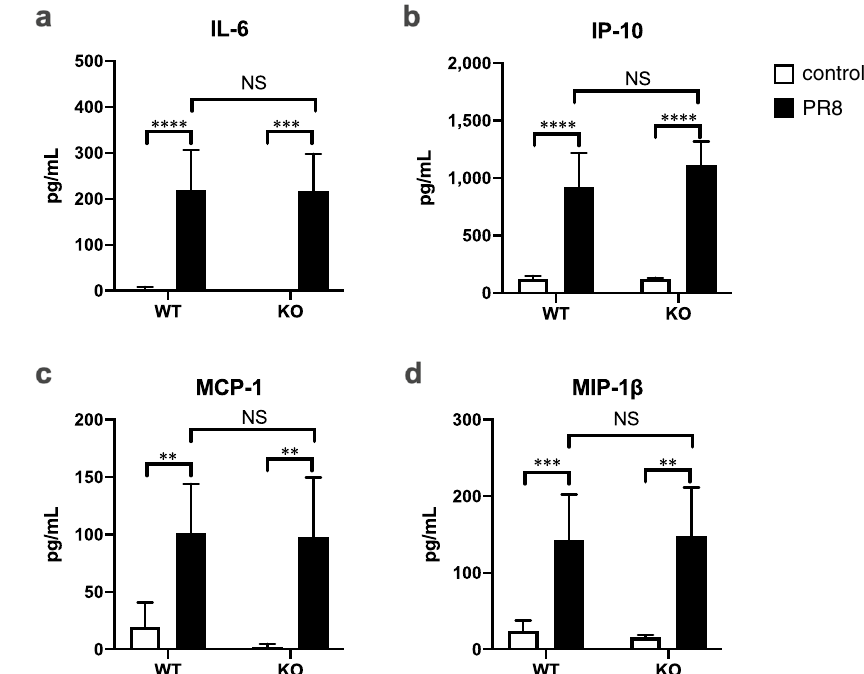
Figure 5. Effect of OLR1 on virus infection-induced systemic inflammation. WT and KO mice were intranasally inoculated with PBS alone or PBS comprising PR8 virus, and serum samples were collected at 6 dpi. Serum levels of ( a ) IL-6, ( b ) IP-10, ( c ) MCP-1, and ( d ) MIP-1β were measured by a multiplex assay. ( a–d ) Bars represent the mean ± SEM of 3 (KO control group) or 8 (the other groups) animals. In each panel, white and black bars indicate data from control and PR8 virus-infected mice, respectively. ** p < 0.01, *** p < 0.005, **** p < 0.0001, two-way ANOVA using a multiple-comparison correction. WT, wild type mice; KO, Olr1 knockout mice; NS, not